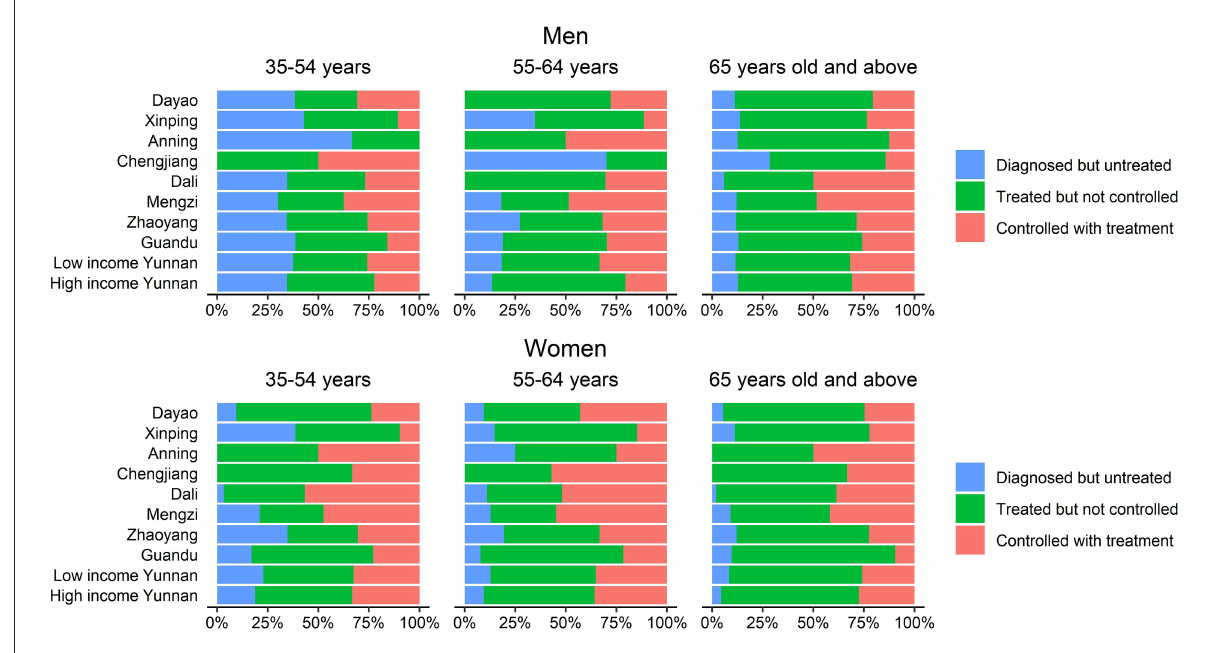
FIGURE6 Distribution of blood pressure management status of hypertensive patients in